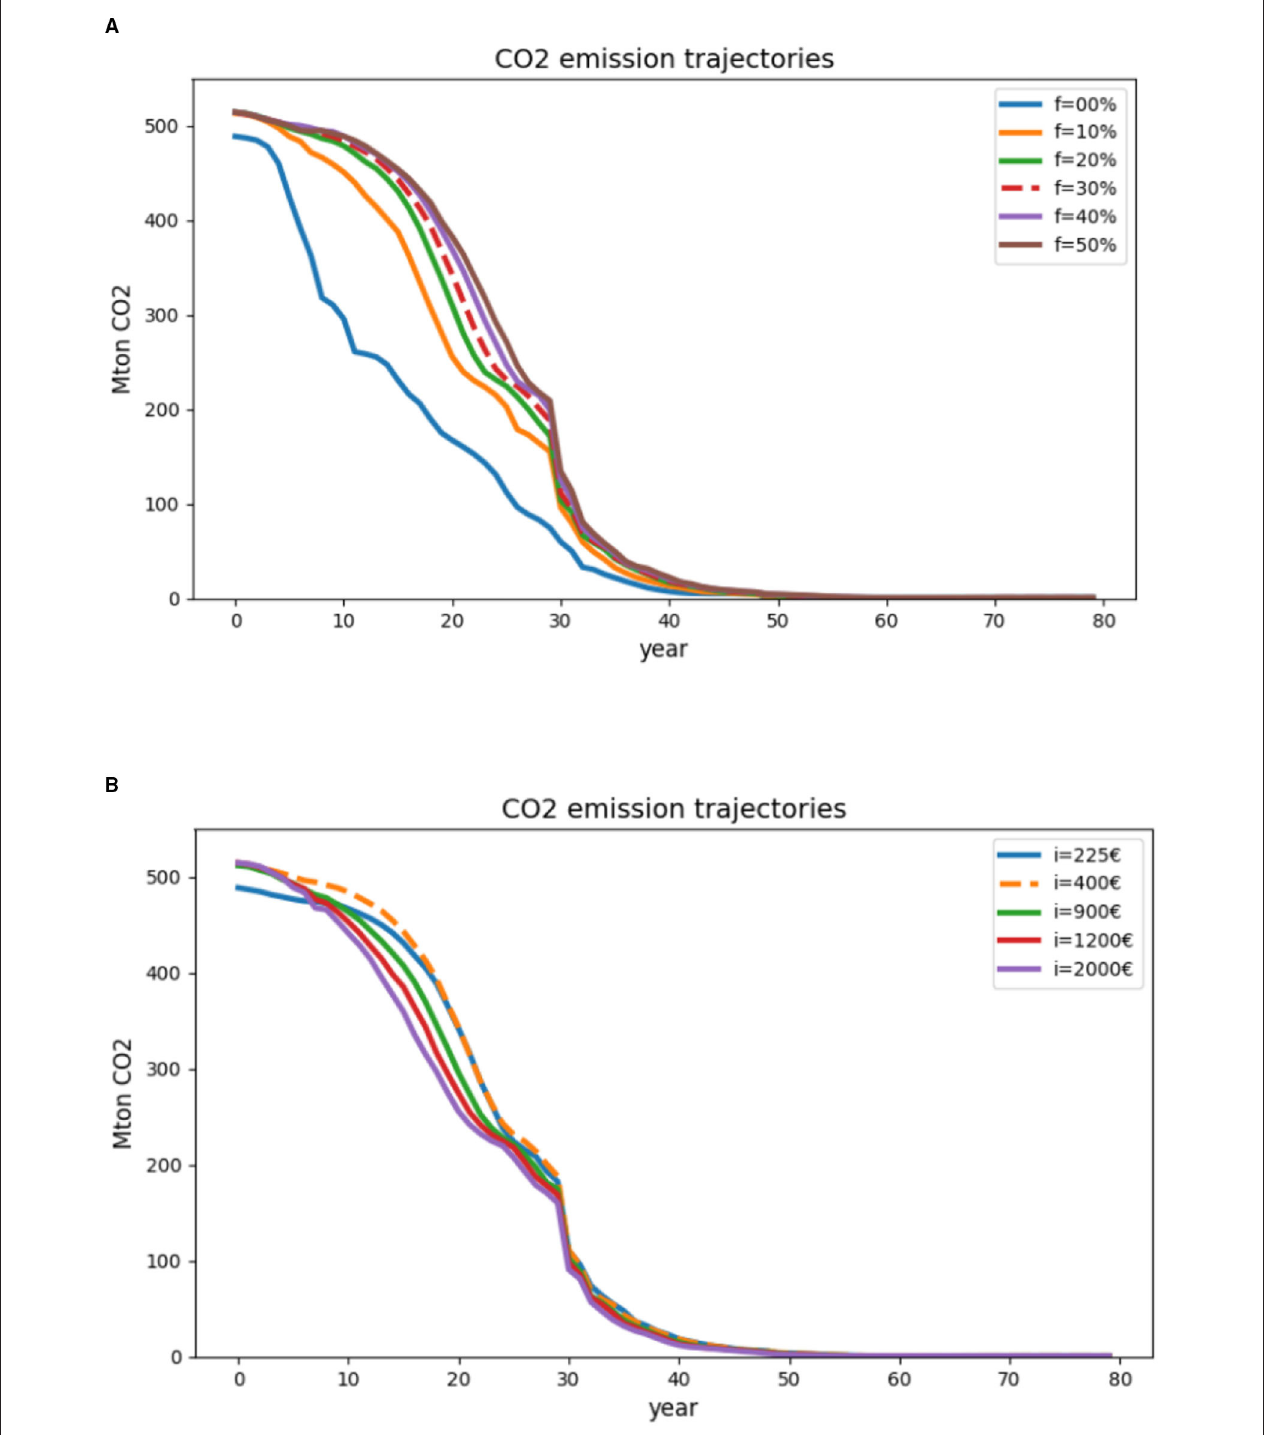
FIGURE 9 | Emission trajectories in cases with different levels of capital accessibility. (A) cases with varying f , which is the fraction of an investment financed by a company’s own capital; (B) cases with varying i , which is the initial capital in a company’s bank account. The dashed line represents the base case ( f = 30% and i = 400M e